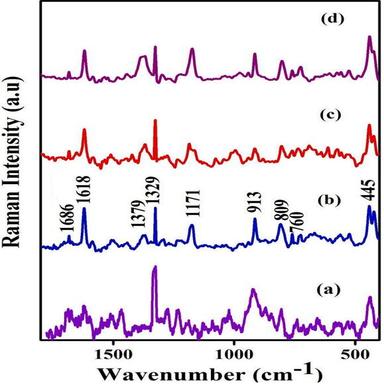
SERS spectra of (a) Leachate (b) GW1 (c) GW2 and (d) GW3.